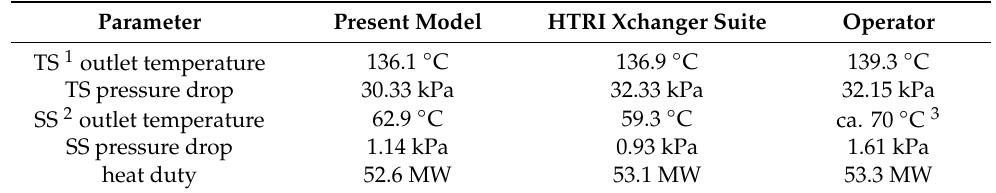
Table 7. Summary of the main results obtained using the two discussed approaches alongside the data provided by the operator of the